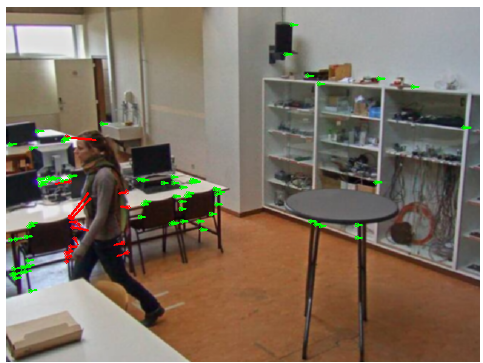
Figure 5. Example of matches found through sparse optical flow matching [35], where the features are selected through the feature detector described in [38]. Points coinciding with foreground locations in the previous frame are discarded immediately. RANSAC is then used to further eliminate outliers (red). The remaining matches (green) are employed to determine the panning/tilting motion of the camera.